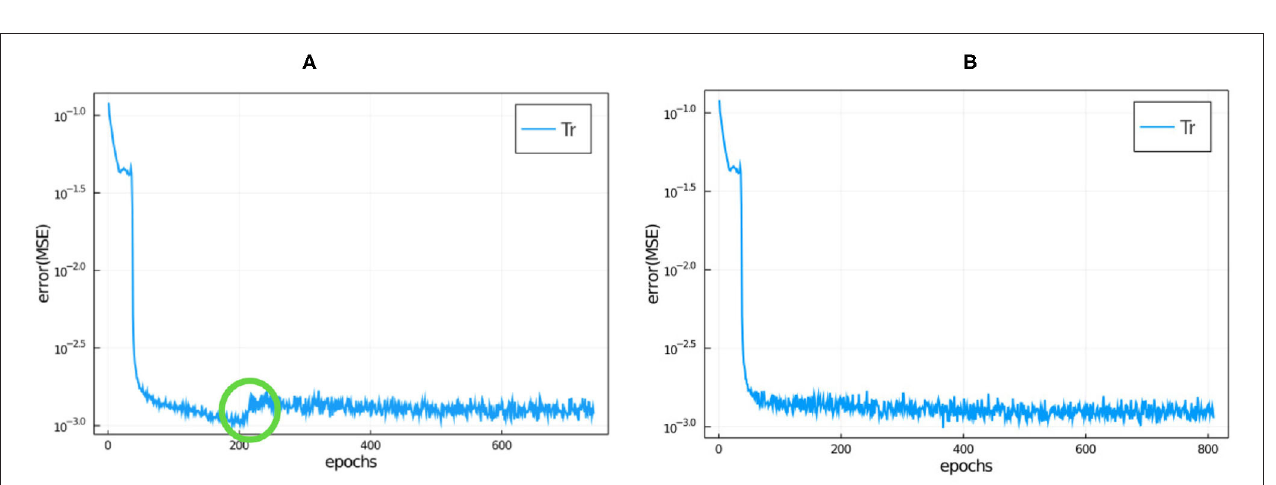
number of roll-backs is 40, i.e., this number is the number of epochs where the jump was higher than the threshold during the